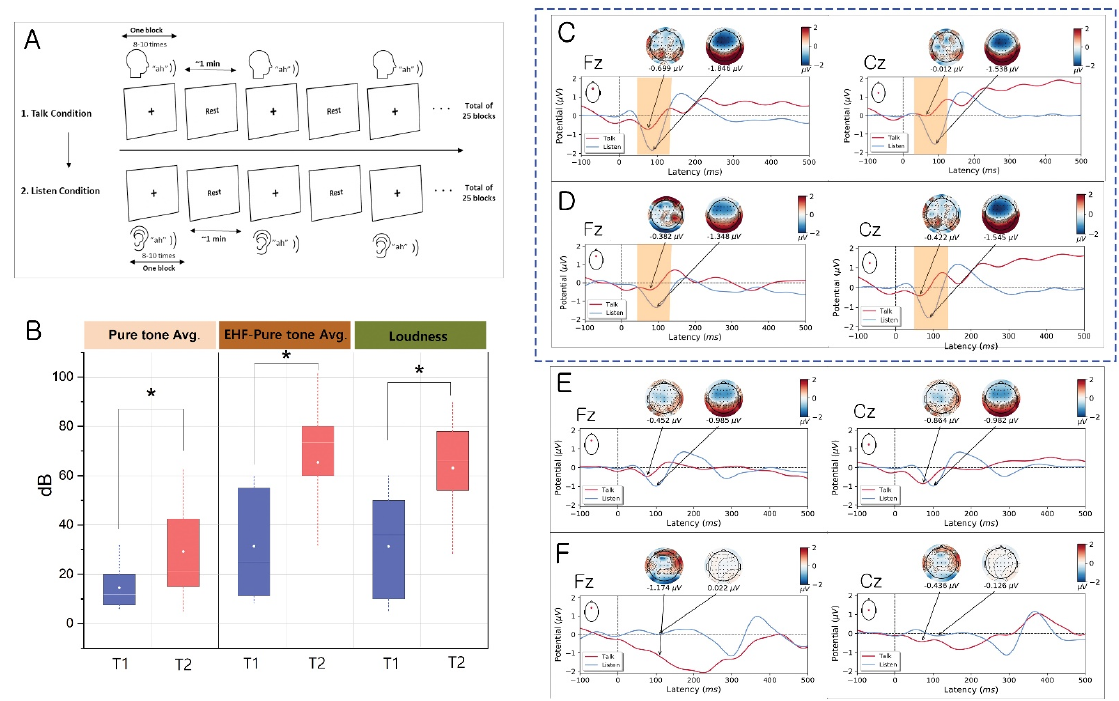
Figure 1. ERP results from Talk and Listen paradigm protocol and group characteristics. ( A ) Illustration of the Talk/Listen paradigm. The paradigm was composed of two tasks (Talk and Listen) performed consecutively. Each task consisted of 25 blocks. In the first task (Talk condition), partici ‐ pants produced the sound “ah” 8 to 10 times. The “ah” utterances were recorded for all blocks; participants then listened to their own recorded utterances during the Listen condition. A “Rest” sign appeared upon the completion of each block, allowing the participant to rest between blocks. ( B ) Representative graph for the T1 and T2 groups. Data are shown as mean ± SD. * indicates statis ‐ tical significance ( p < 0.05). ( C – F ) Grand ‐ averaged ERP time courses in the Talk condition (solid red line) and Listen condition (solid blue line) for the healthy controls ( C ), T1 ( D ), T2 ( E ), and schizo ‐ phrenia groups ( F ) at the Fz and Cz electrodes and the topographies of their maxima. Note the sig ‐ nificant attenuation of auditory N1 amplitude during the Talk condition, compared with the Listen condition, in the healthy control ( C ) and T1 groups ( D ). Color bar indicates amplitude ( μ V). All topographies are shown from the vertex view with the nose at the top. 2.2. Equipment Setup The experiment was performed in a soundproof room with each participant seated upright in a comfortable chair facing a monitor where the experimental stimuli were pre ‐ sented. A recording microphone was placed 3–5 cm in front of the participant’s mouth and binaural insert earphones (EARTONE 3A ® , 3M Company, Indianapolis, IN, USA) were used for sound stimuli delivery. Two separate computers were installed outside of the participant testing room for EEG recording and stimuli presentation, respectively. The stimulus presentation computer was connected to the microphone to record the partici ‐ pant’s utterances (during the Talk condition), which were later delivered to the partici ‐ pants using the insert earphones. In addition, the stimulus presentation computer was linked to the EEG recording computer to enable the insertion of stimulus ‐ locked triggers in the EEG data. 2.3. Talk/Listen Paradigm